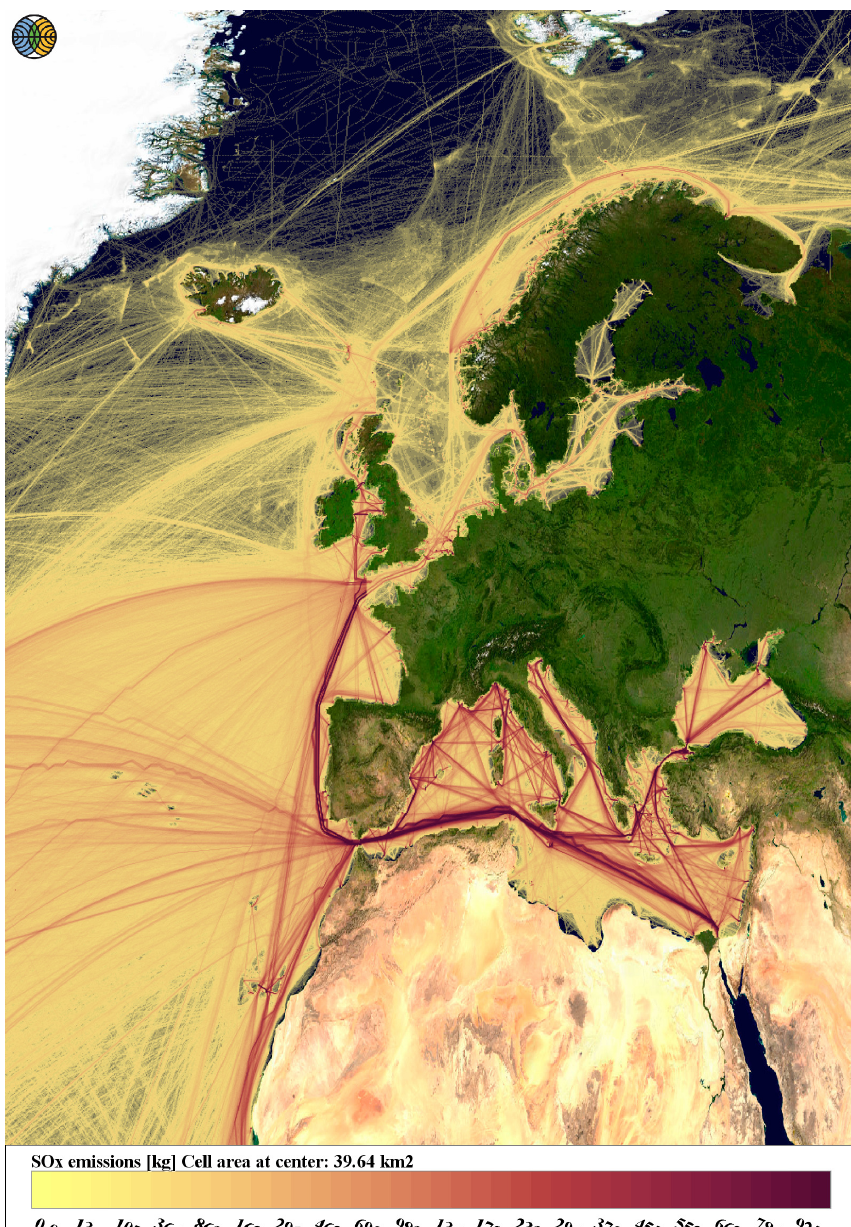
Figure 5. The predicted SO x emissions from ships in Europe in 2018, computed using the STEAM model (e.g. Johansson et al., 2017). Use of low-sulfur fuels and SO x scrubbers is concentrated to the North Sea and Baltic Sea ECAs. Background map ©US Geological Survey, Landsat8